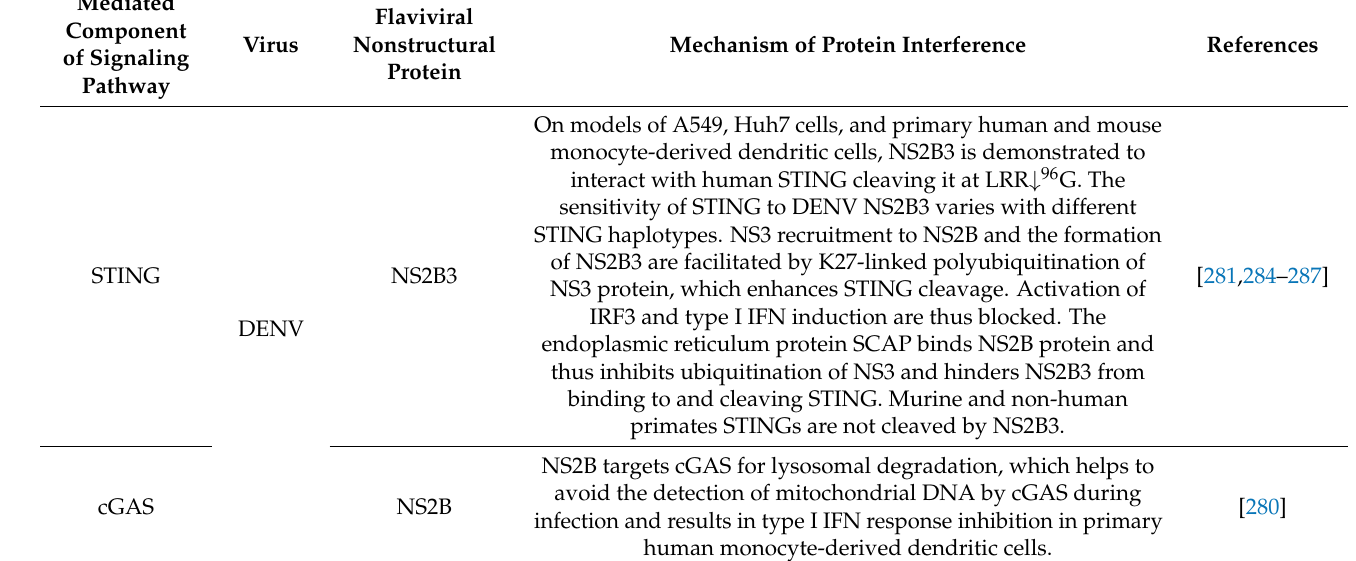
Table 5. Flaviviridae nonstructural proteins’ interference with cGAS-STING